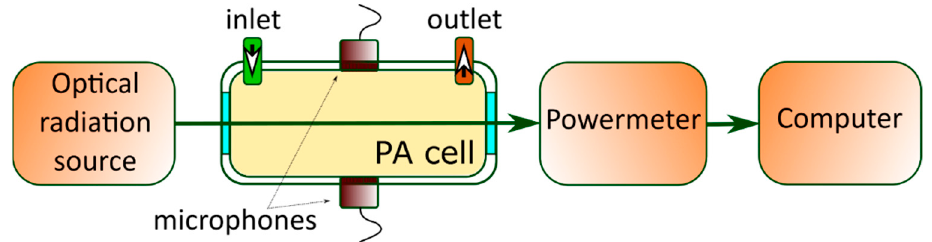
Figure 10. Schematic sketch view of the PAS setup’s configuration.